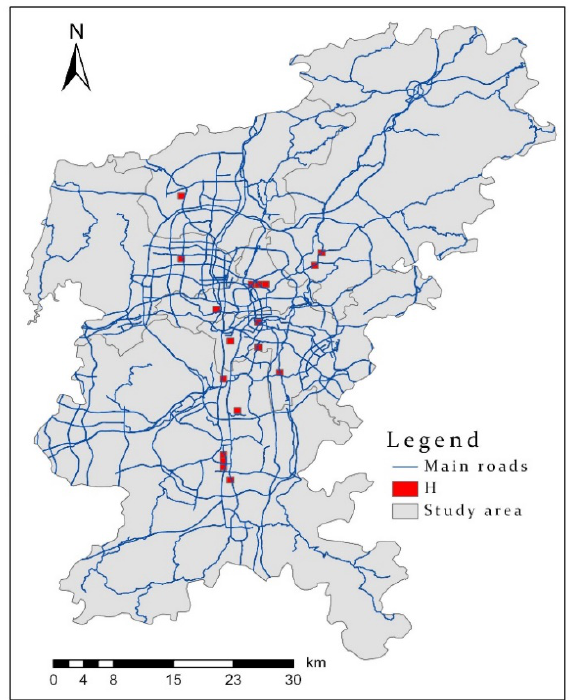
Figure 11. Eighteen recommended sites with high market potential. Table 6. Specific surroundings of samples in recommended sites.